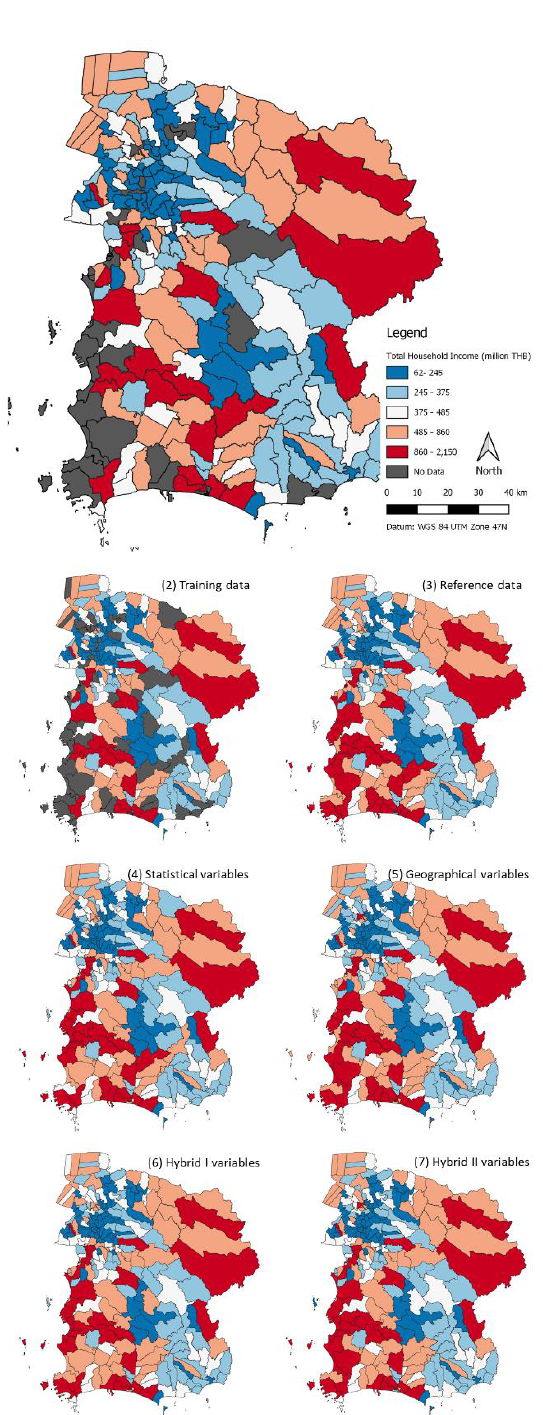
Figure 8. The imputation results of missing sub-district household income by four different sets of